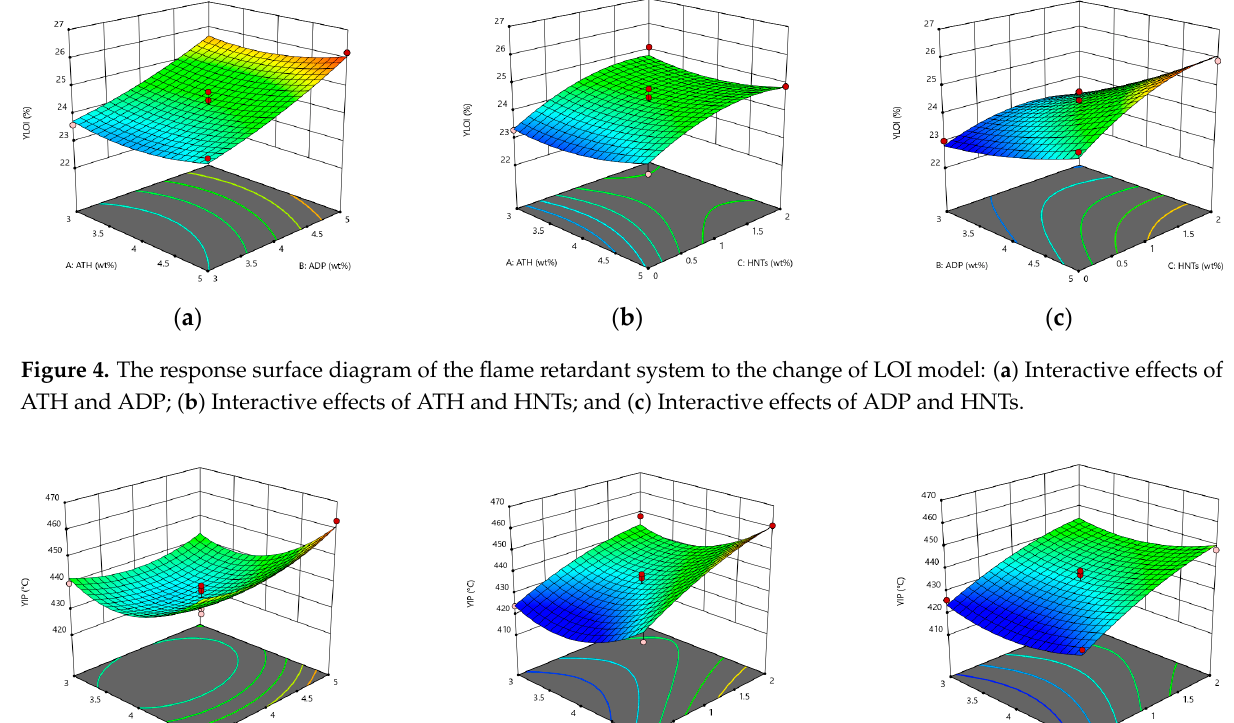
Figure 4. The response surface diagram of the flame retardant system to the change of LOI model: ( a ) Interactive effects of ATH and ADP; ( b ) Interactive effects of ATH and HNTs; and ( c ) Interactive effects of ADP and HNTs.